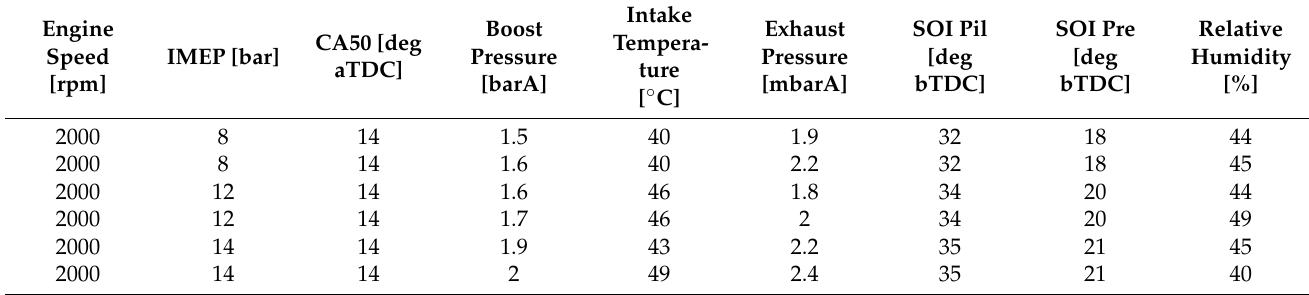
Table 10. Engine operating conditions for ID model calibration running GCI mode with EGR rate equal to